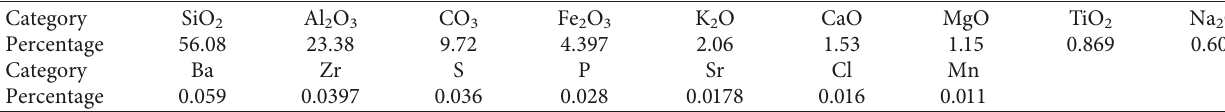
Figure 2: X-ray diffraction patterns of the gangue samples. Table 2: Content of elements or compounds of the gangues